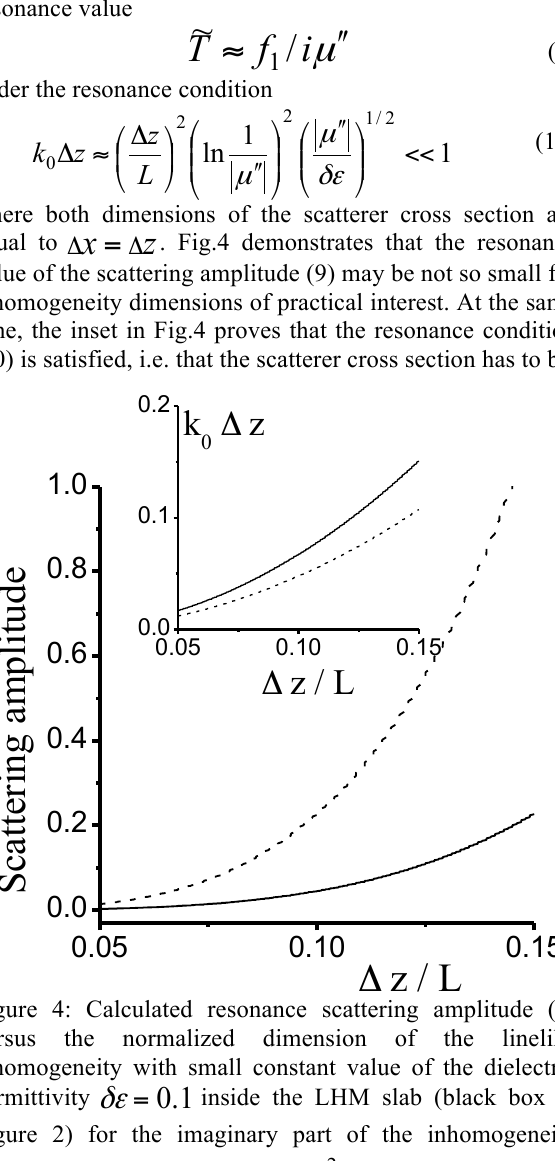
Figure 2) for the imaginary part of the inhomogeneity magnetic permeability 2 10 − = ʹ′ʹ′ µ (solid curves), 3 10 − (dashed curves) and the magnetic permeability real part equal to 1 − = ʹ′ µ . The inset visualizes the inequality